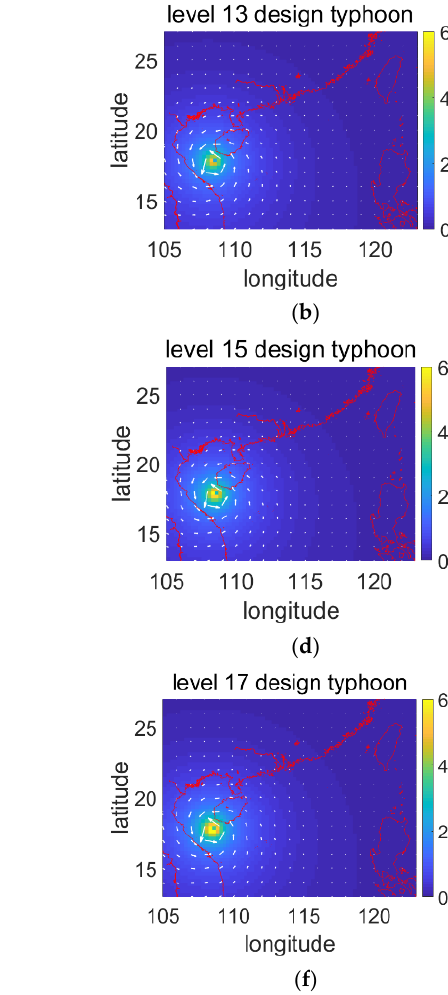
Figure 5. Maximum wind speeds (m/s) of level 12 – 17 designed typhoon. ( a ) level 12 ( b ) level 13 ( c ) level 14 ( d ) level 15 ( e ) level 16 ( f ) level 17.